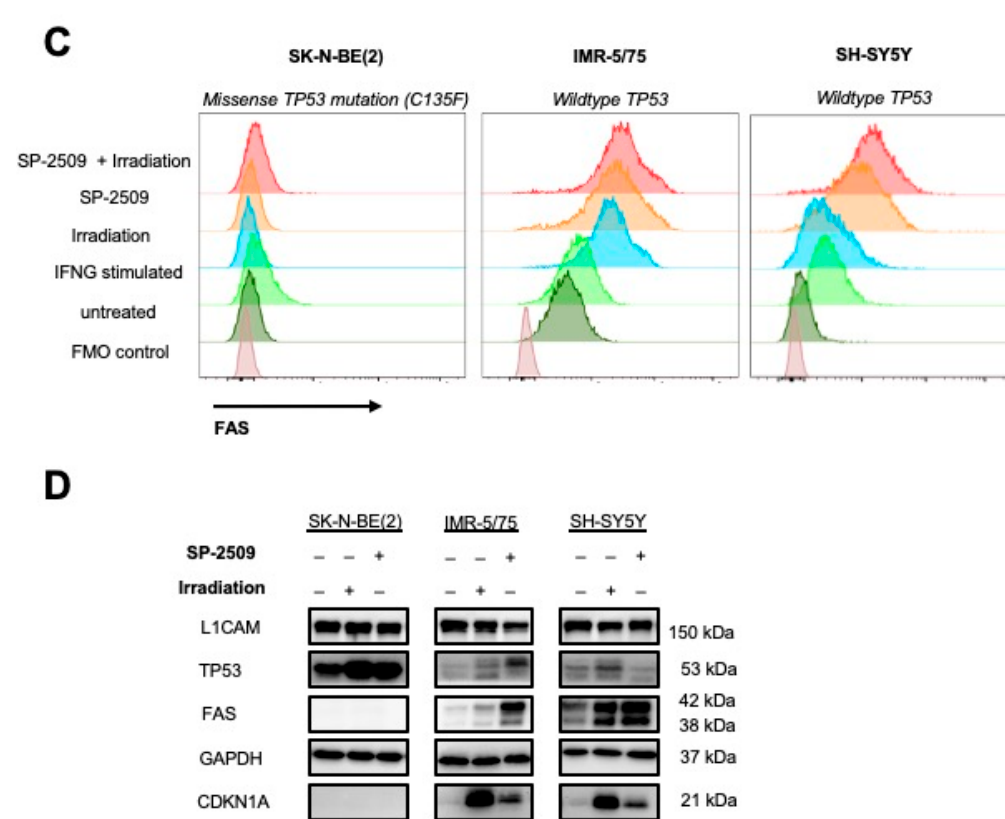
Figure 2. Inhibiting KDM1A strongly enhanced FAS on neuroblastoma cell surface. ( A ) Illustration of FAS regulation in tumor cells. ( B ) Pearson correlations between FAS and KDM1A expression on the left side across 47 samples [22] and on the right side across 51 samples from primary neuroblastomas [23] (source: R2: Genomics Analysis and Visualization Platform (http://r2.amc.nl, accessed on 27 September 2021)). ( C ) Flow cytometrically determined FAS surface expression in neuroblastoma cell lines after 72 h of treatment with 0.5 µM KDM1A inhibitor (SP-2509), irradiation with 2 Gy, or a combination of both (mean ± SD, n = 3). ( D ) L1CAM, TP53 and FAS protein expression in neuroblastoma cells after 72 h of treatment with 0.5 µ M KDM1A inhibitor (SP-2509), irradiation with 2 Gy, or a combination of both. GAPDH served as loading